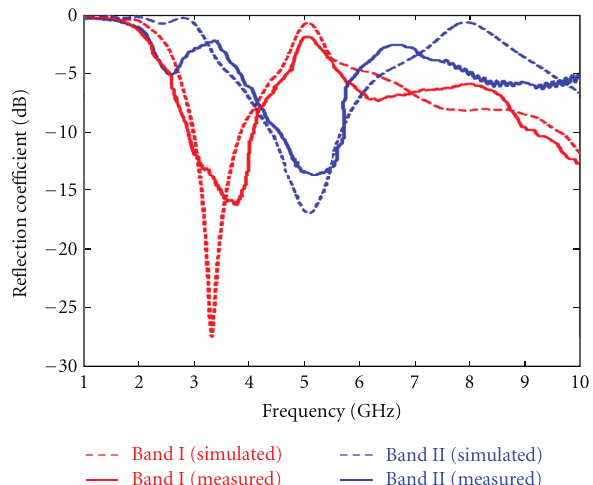
Figure 4: Simulated (dashed lines) and measured (solid lines) reflection coe ffi cient curves when antenna is reconfigured in Band I: 3-4GHz and Band II: 4.5–5.5